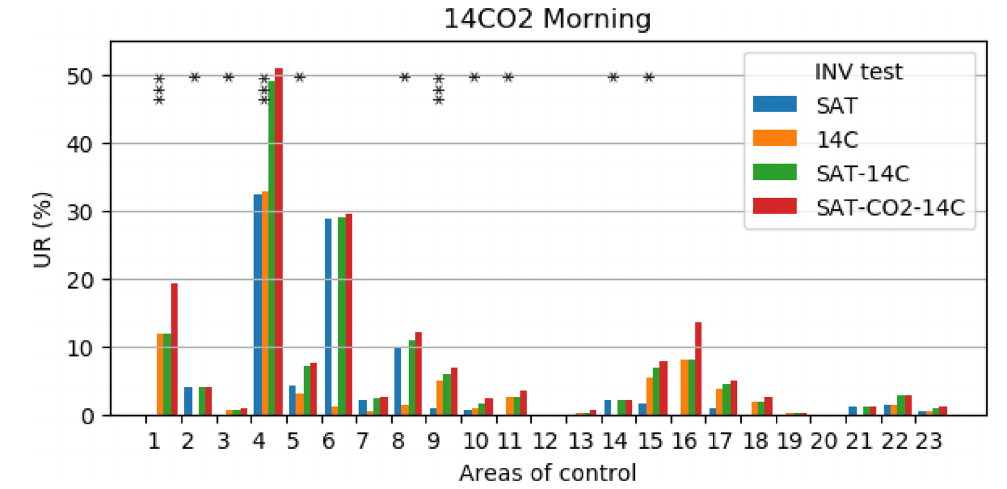
Figure A5. Uncertainty reduction in INV-SAT, INV-14C, INV-SAT-14C, and INV-SAT-CO2-14C inversions for morning budgets of FF emissions of each controlled area in the main area of interest. The number of stars indicates the number of stations in each controlled area. The names of the controlled areas are listed in Table 1.